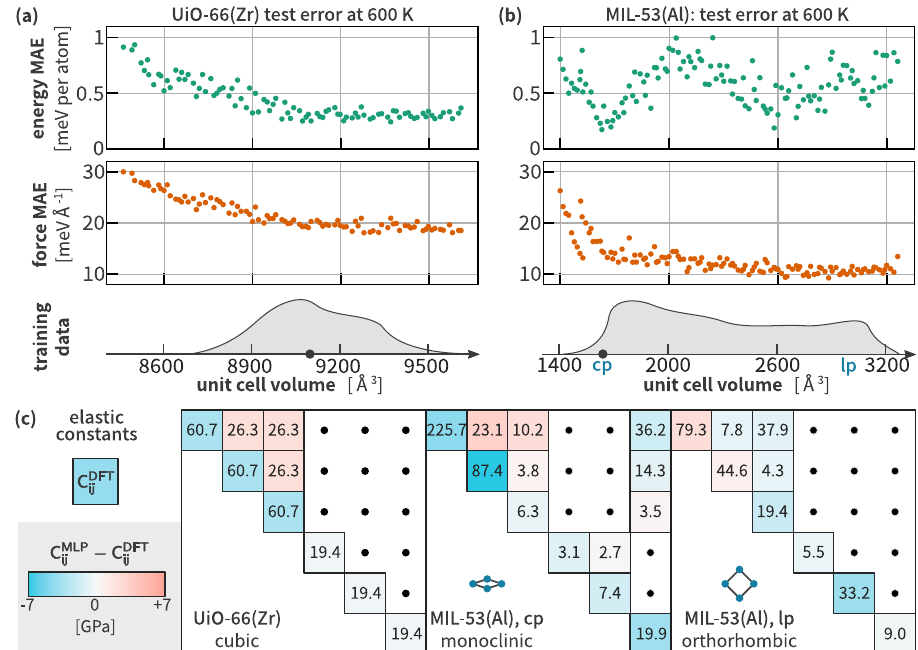
Fig. 4 Validation of the obtained potentials for UiO-66(Zr) and MIL-53(Al). a , b Energy and force MAEs on independent test sets and a smoothed histogram of the training data sampled using incremental learning; the unit cell volume of the initial con fi guration is indicated with a black dot. Additional computational details are provided in the Methods section. c Stiffness matrix for UiO-66(Zr) and both phases of MIL- 53(Al) as calculated with the MLPs. Each square is color-coded based on the difference between the MLP prediction and the DFT reference values; the latter are explicitly shown inside each square. Black dots indicate stiffness constants which are zero due to symmetry considerations; see Supplementary Note 3 for more